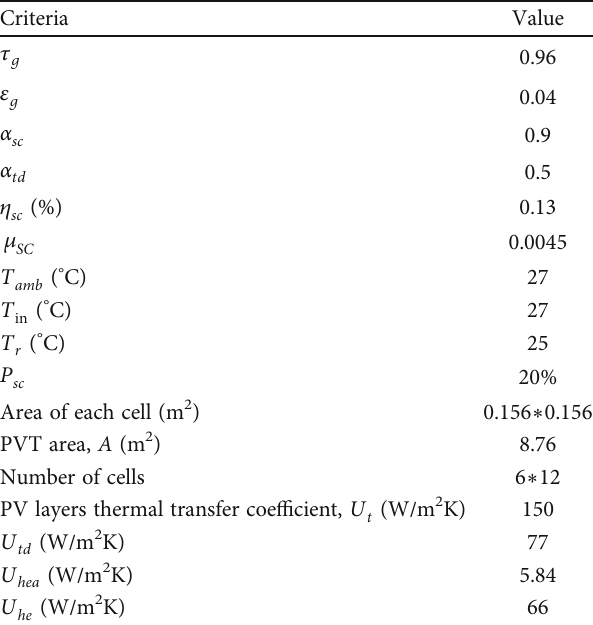
Table 2: PVT properties [3, 8,